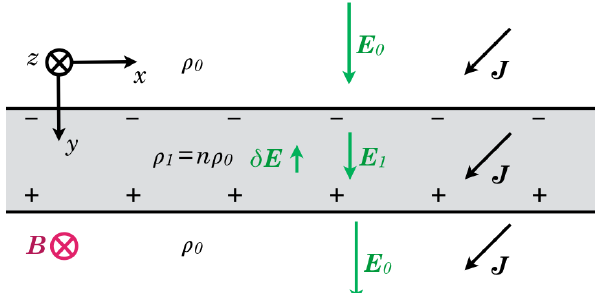
Figure 1. A slab of denser plasma extending perpendicular to the background electric field E 0 and extending parallel to B (e.g. be- tween two L shells). In order for the Pedersen current across the boundaries to be conserved, E 1 within the slab will be lower than E 0